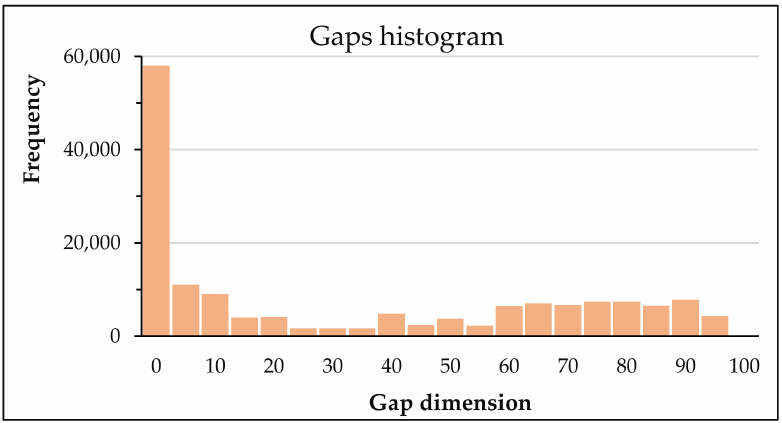
Figure 5. Histogram of intraday gaps in the consumption